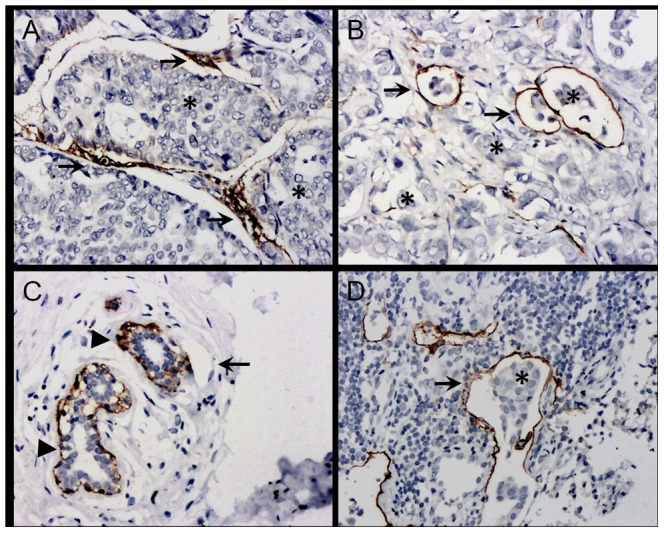
Immunohistochemical staining of D2-40.
A. Lymph vascular structures in the central tumor were linear, flattened, cluttered and densely arrayed; B. Stained lymphatic microvessels (long arrows) in a peripheral tumor with dilated tubes. Tumor cell clusters (indicated by asterisks) were not stained. A cluster of tumor cells in a stained vessel was recognized as lymphatic vessel invasion (LVI); C. Benign breast epithelium. Luminal epithelial cells with D2-40− staining. Myoepithelial cells from normal ducts and lobules exhibited D2-40+ immunostaining (arrow heads), but with a granular, branching membranous staining pattern distinct from the characteristic staining pattern of lymphatic endothelium shown in B. Capillary vessels were not stained (indicated by long arrow); D. Metastatic lymph nodes. Dilated lymphatic microvessel sub-capsular metastasis with no tumor cell staining (indicated by asterisks), defined as ‘tumor emboli’ (indicated by arrow). Magnification, 200×.